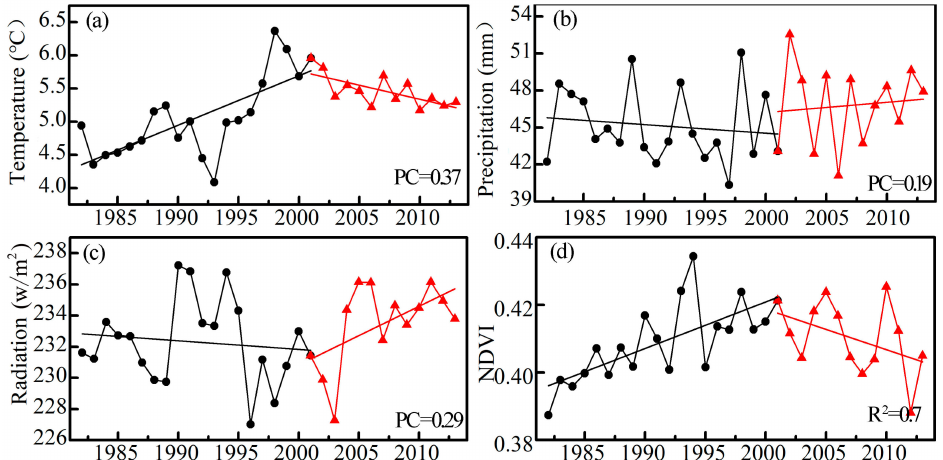
Figure 6. Climatic factors and NDVI variations in central China region from 1982–2013. ( a ) Temperature (T); ( b ) precipitation (P); ( c ) radiation (R); and ( d ) NDVI; the black line and the red line represent the changing trends before and after the temperature change. PC represents the partial correlation coefficient of each climatic factor with NDVI, excluding the other two meteorological variables, and R 2 represents the coefficient of determination between the NDVI and the meteorological factors. The relationship between NDVI and the climate factors is NDVI = 0.01T + 0.00002P + 0.001R +